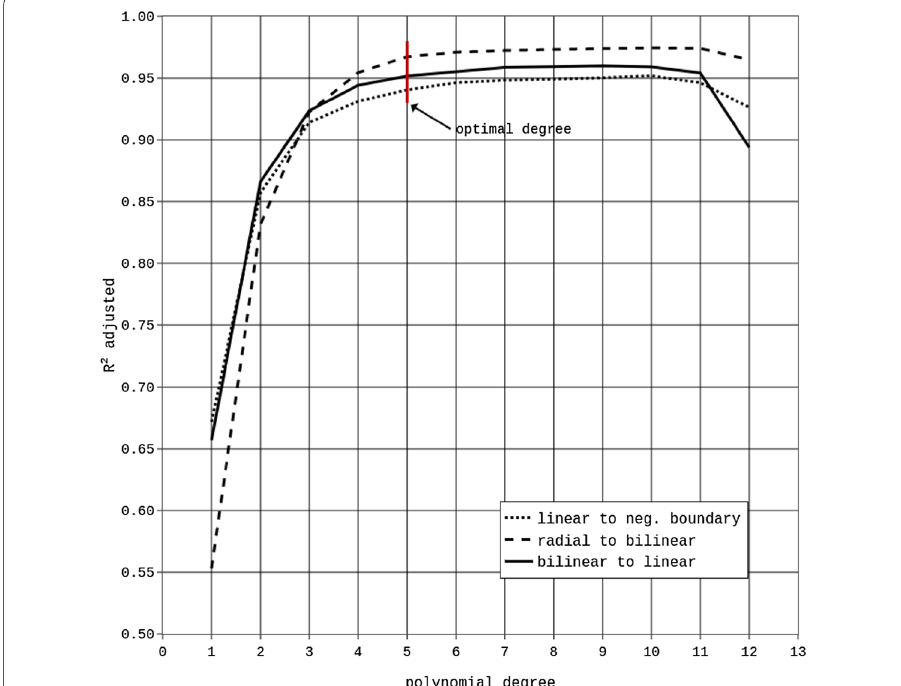
Fig. 7 Determination of optimal degree for polynomial regression; R 2 -adjusted versus polynomial